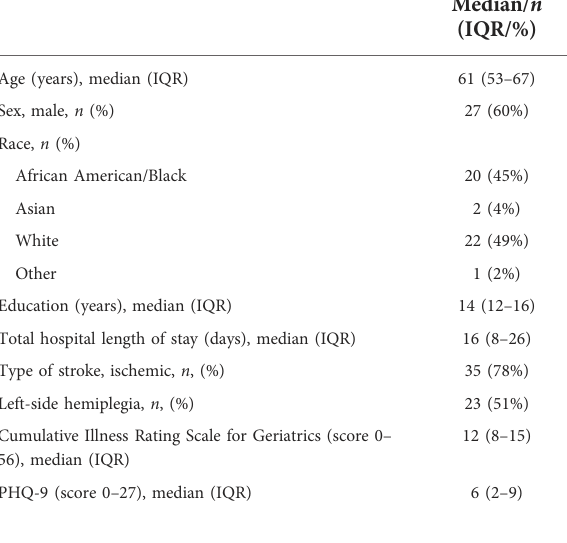
TABLE 1 Participant characteristics ( n =45). Values are number (%) or median (IQR) as indicated.